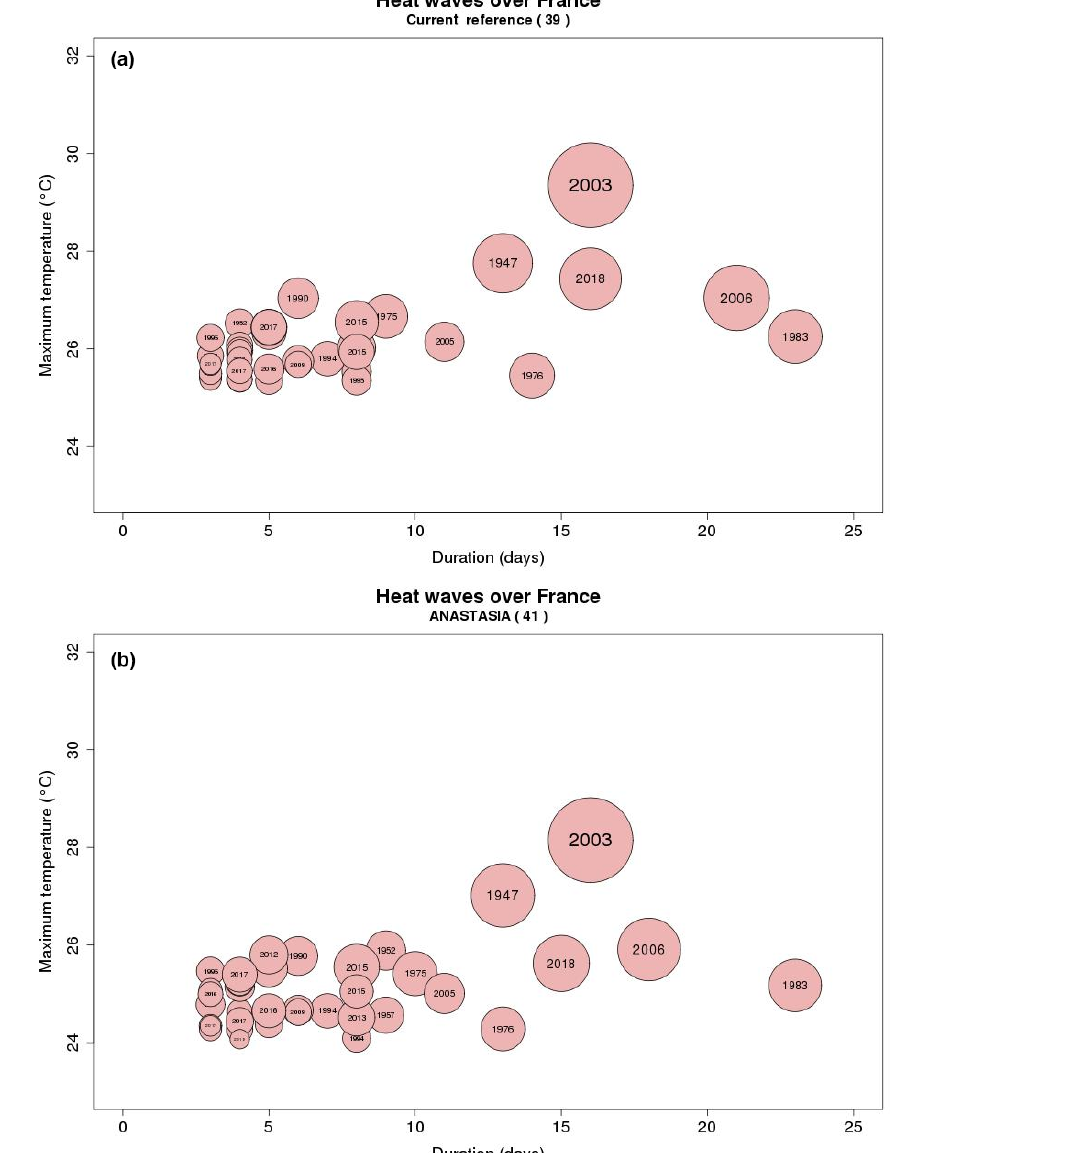
Figure 7. 3-D graphic representations of heat waves (1947–2018 period) over France for the current reference (a) and for ANASTASIA production (b) . Each bubble represents a heat wave event: the duration ( x -axis), the maximum temperature ( y -axis), the global intensity (diameter of each bubble) and the year can be found on the